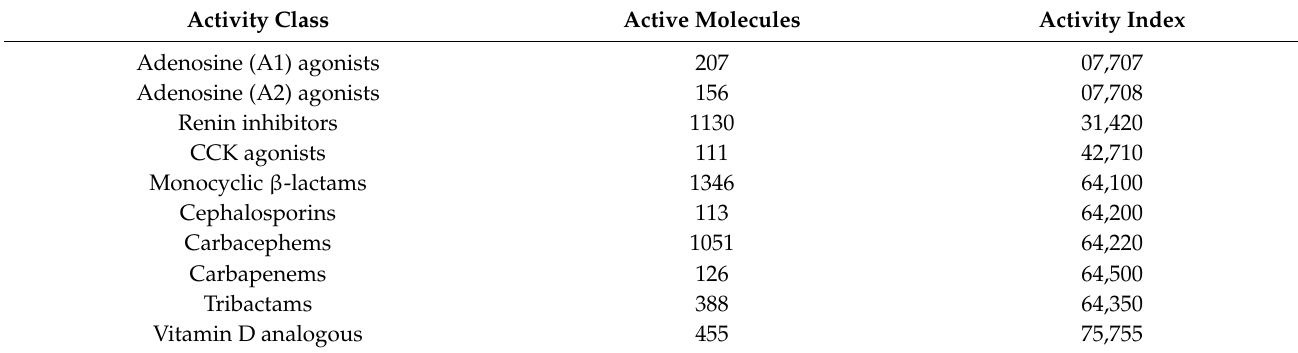
Table 2. The MDDR-DS2 structure activity classes.